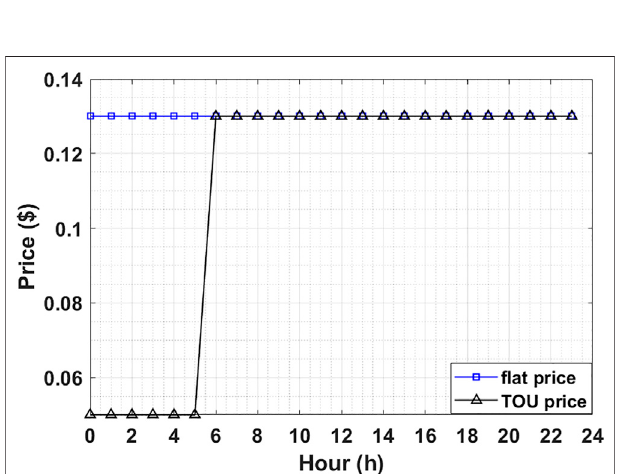
FIGURE 2 | Comparison of prices between the fl at price and TOU price.